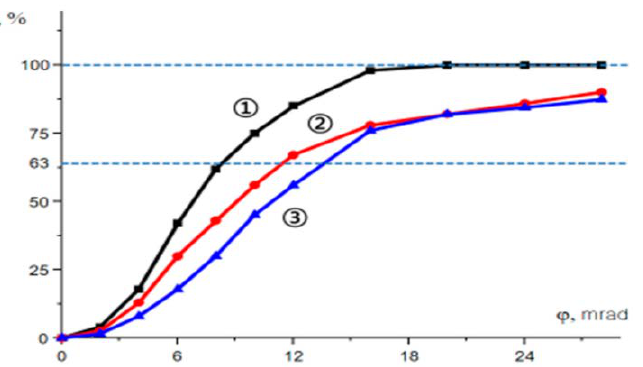
Figure 11. The angular distribution of Ti:Sapphire laser energy for DD at: 1—W PUMP = 0.5 J/cm 2 ; 2— W PUMP = 0.75 J/cm 2 ; 3—W PUMP = 1.05 J/cm 2 . Reprinted with permission from ref. [18]. Copyright 2019 © The Optical Society.